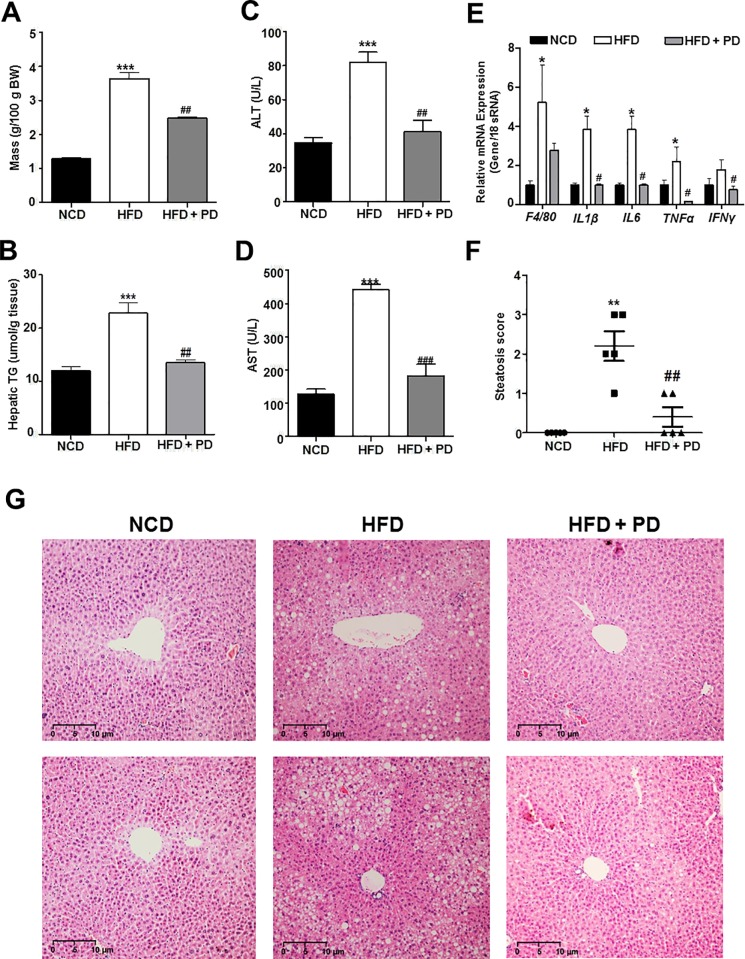
Effect of EGFR inhibition on hepatic steatosis in HFD-fed mice.(A) The weight of liver tissue (g/100 g body weight). (B) Hepatic triglyceride(TG) level (μmol/g tissue). (C) Alanine transaminase (ALT) (U/L) levels. (D) Aspartate transaminase (AST) (U/L) levels. (E) The m RNA levels of selected inflammatory genes were showed by real time PCR for liver tissue. (F) Steatosis score. Pathology scores were as follows: 0, no significant lesions (0%); 1, minimal (<10%); 2, mild (10–25%); 3, moderate (25–40%); 4, marked (40–50%); and 5, severe (>50%) (G) Representative images of H&E staining of liver sections. Scale bars = 10 μm. NCD, NCD-fed mice (NCD, black bars); HFD, untreated HFD-fed mice (white bars); HFD+PD, HFD-fed mice treated with PD153035 (gray bars). Data are expressed as the mean ± SEM. * P < 0.05, ** P < 0.001, *** P < 0.0001 NCD vs. HFD group. # P < 0.05, ## P < 0.001, ### P < 0.0001 HFD vs. HFD+PD group.